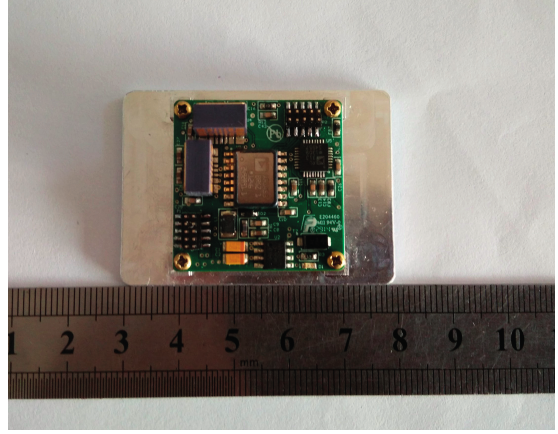
Figure 1. Wearable multi-sensor system designed by our lab.